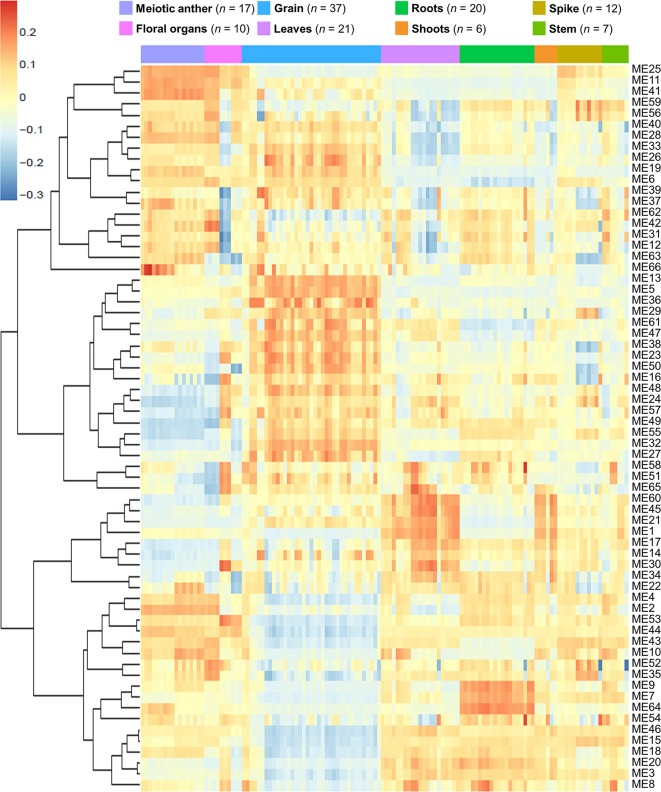
Heatmap plotting of MEs values in relationship to tissue samples. n indicates number of samples.